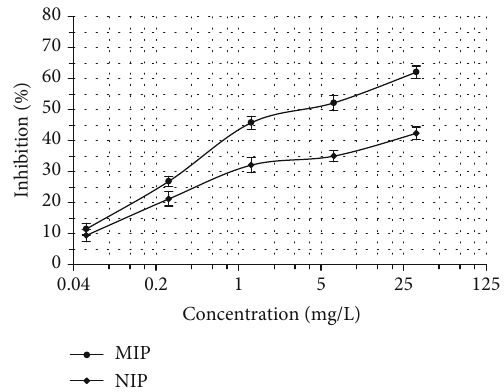
Figure 4: Standard BELISA competition curves for sulfadiazine at concentrations from 0.0512 to 160mg/L in